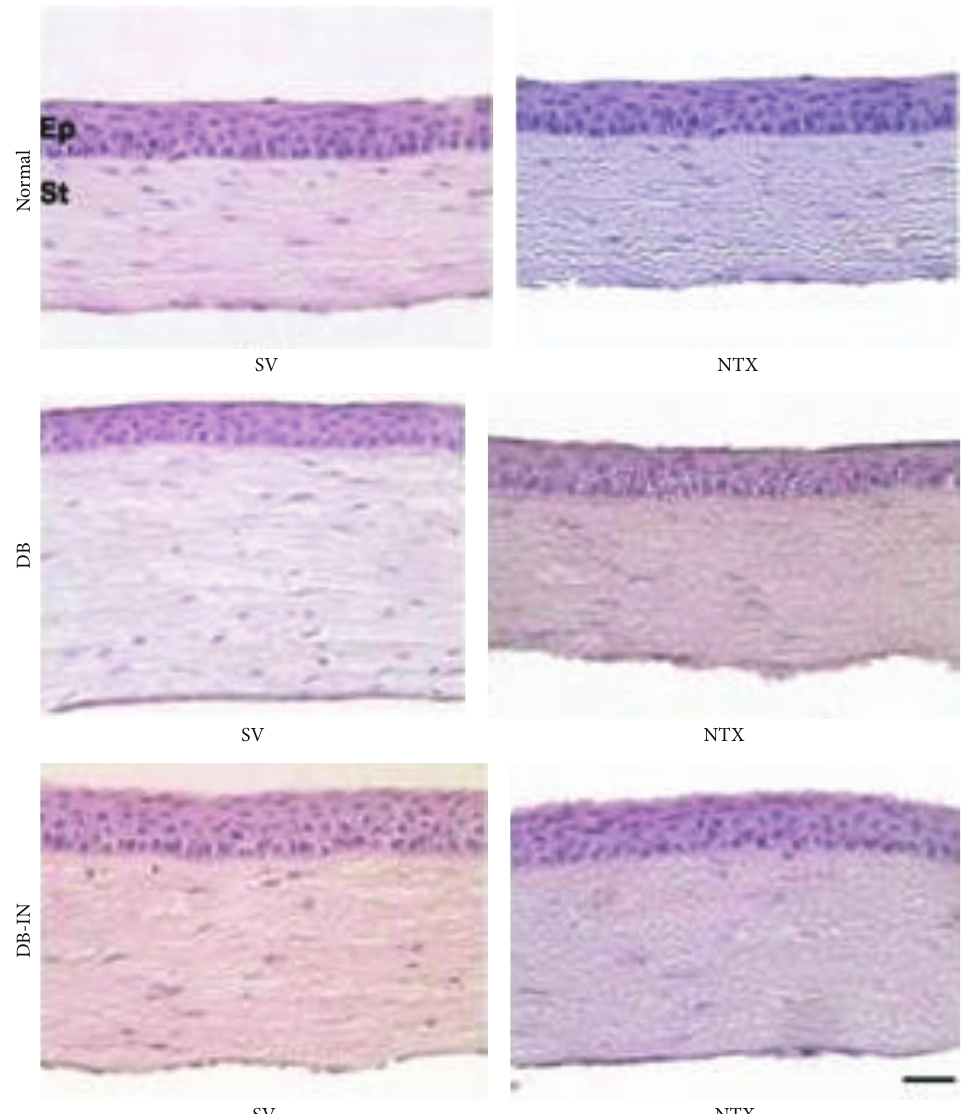
Figure 11: Toxicity evaluation of NTX-treated rat cornea. Corneal thickness, endothelial cell number, and evidence of epithelial apoptosis, necrosis, or organization were determined for topical 10 −3 to 10 −7 M NTX administered q.i.d. × 7 days to corneas of type 1 diabetic rats. Photomicrographs of histological sections of the rat peripheral cornea stained with hematoxylin and eosin from animals in normal, diabetic (DB), and diabetic-insulin (DB-IN) groups at 2 weeks after the conclusion of 7-day exposure (4 times daily) of 10 3 M naltrexone (NTX) or sterile vehicle (SV). The morphology of the cells and tissues was similar between groups, and no pathologic changes were detected in corneas exposed to vehicle or 10 3 –10 7 M NTX (data not shown for treatment with 10 −4 , 10 −5 , 10 −6 , or 10 −7 M NTX). Ep: epithelium; St: stroma. Bar = 40 m (derived from [42]). These photomicrographs are of rat peripheral cornea treated with the topical 10 −3 M NTX administered q.i.d. × 7 d or